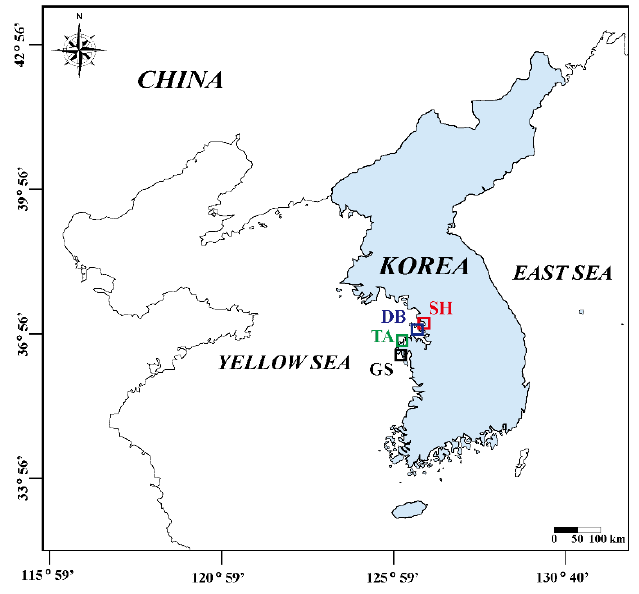
Figure 1. Locations of the four study areas along the west coast of Korea. Red, blue, green, and black rectangles represent SH, DB, TA, and GS tidal flats, respectively. Table 1. Overview of the study area, the month of sample collection, and measurements of each species.